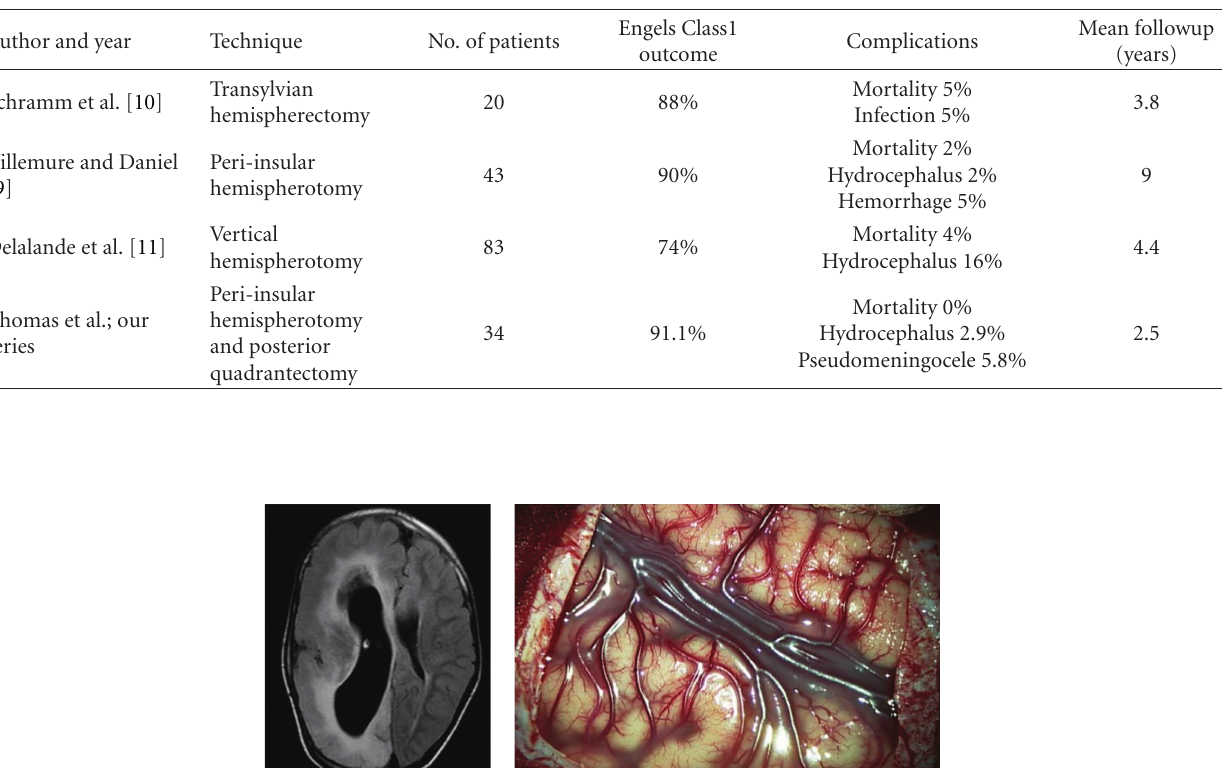
Table 4: Comparison of surgical techniques, seizure outcomes, and complications.